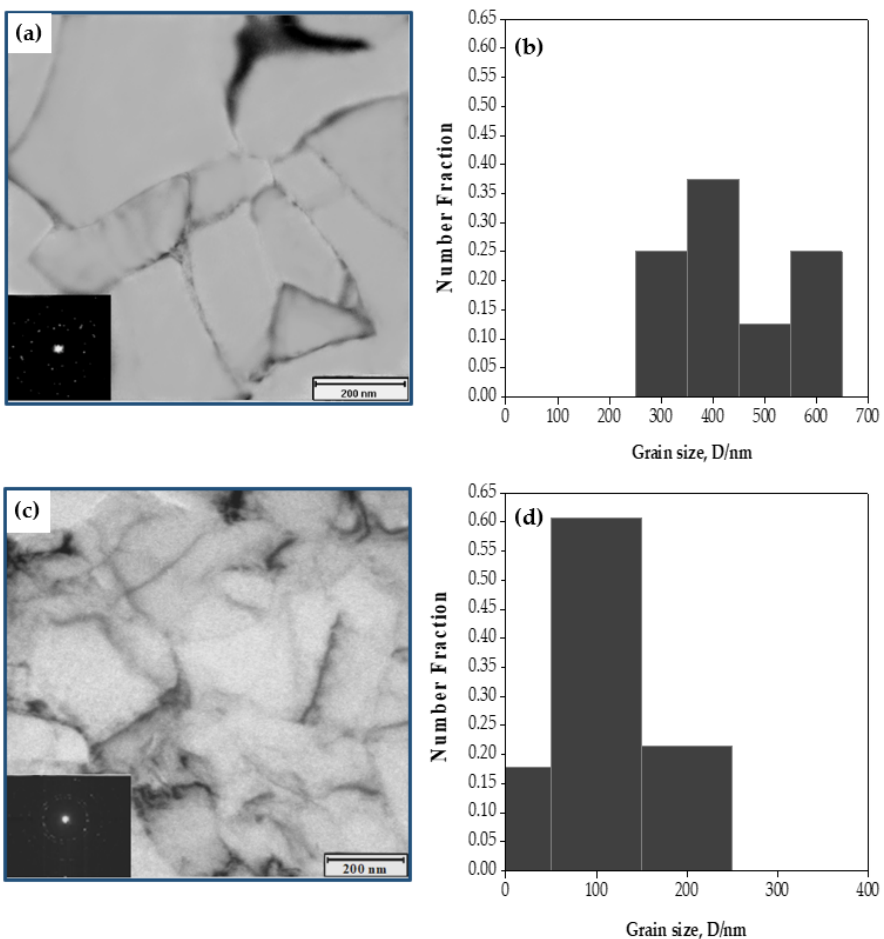
Figure 5. TEM photomicrograph of the microstructure and the corresponding grain size distribution of brass tubes processed in ( a , b ) 1 pass and ( c , d ) 2 passes.